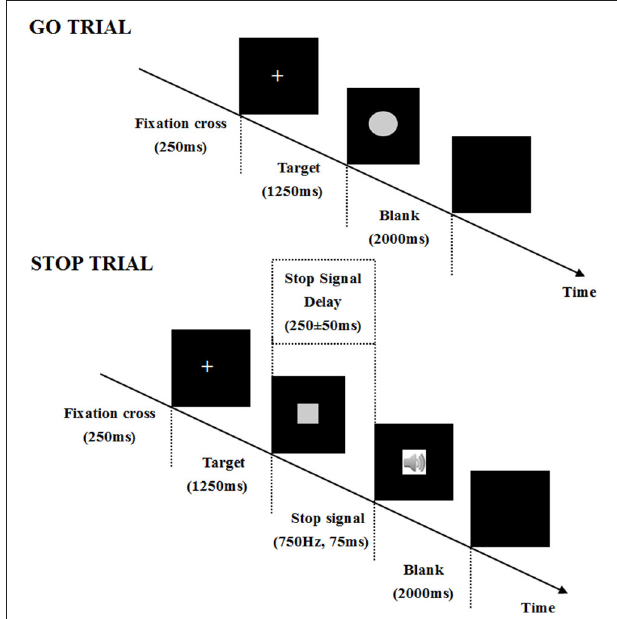
FIGURE 1 | Depiction of a go and a stop trial course in the stop-signal task. In this paradigm, subjects are asked to perform an auditory two-choice reaction task. In the go trials, participants need discriminate the shape of a stimulus (a square corresponds to a left response “Q” and a circle corresponds to a right response “P”). Each trial begins with a central fixation cross (250ms), then a square or circle is presented for 1,250ms in a randomized order. The inter-trial interval is a blank screen of 2,000ms. In the stop trials, occasionally, a tone (i.e., the stop-signal, 750Hz, 75ms) is presented shortly after the stimuli onset (a square or circle). Subjects are instructed to withhold their response when the tone occurs. In the stop-signal trials, the stop-signal is presented after a variable stop-signal delay (SSD; i.e., the delay between the onset of a go stimulus and the onset of a stop-signal). SSD is initially set at 250ms and is adjusted dynamically with the staircase tracking procedure: when inhibition is successful, SSD increases by 50ms; when the inhibition is unsuccessful, SSD decreases by 50ms.